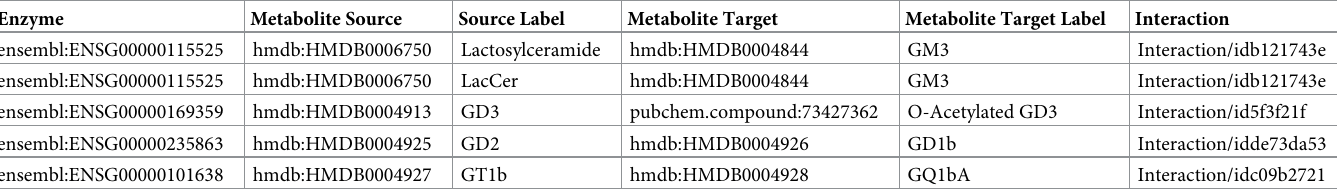
Table 9. Sphingolipid conversion interactions. In the table the enzyme for the conversion is given along with the metabolite source and its label along with the metabolite target along with its label and completed with the interaction id for the conversion.